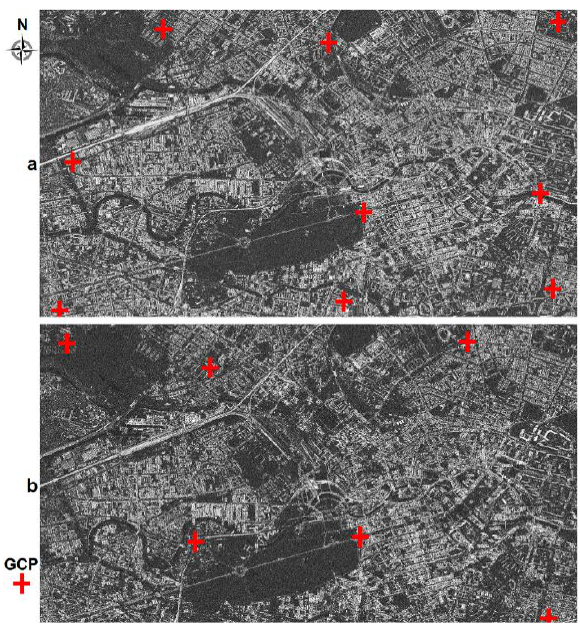
Figure 3. Coherence maps and GCP distributions (a= InSAR-pair 1, b= InSAR-pair